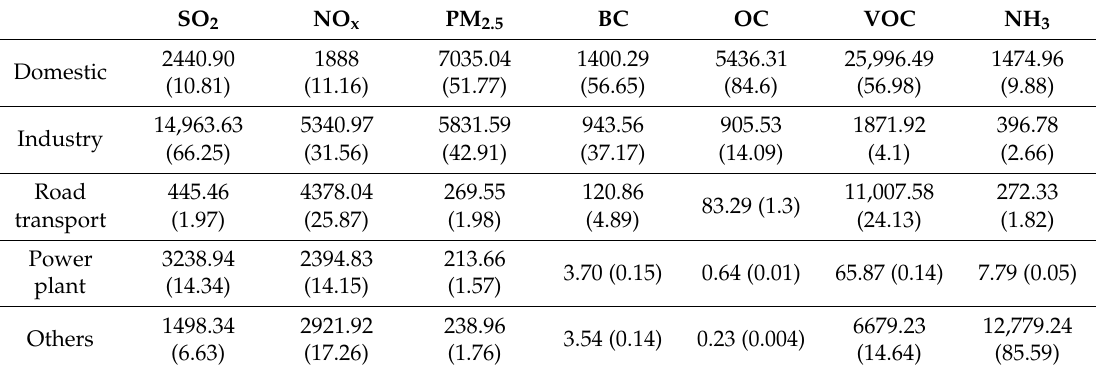
Table A1. Contributions of emission sectors to total emissions of air pollutants in d03 (ton / month). Parentheses show sectoral contributions in % to the total